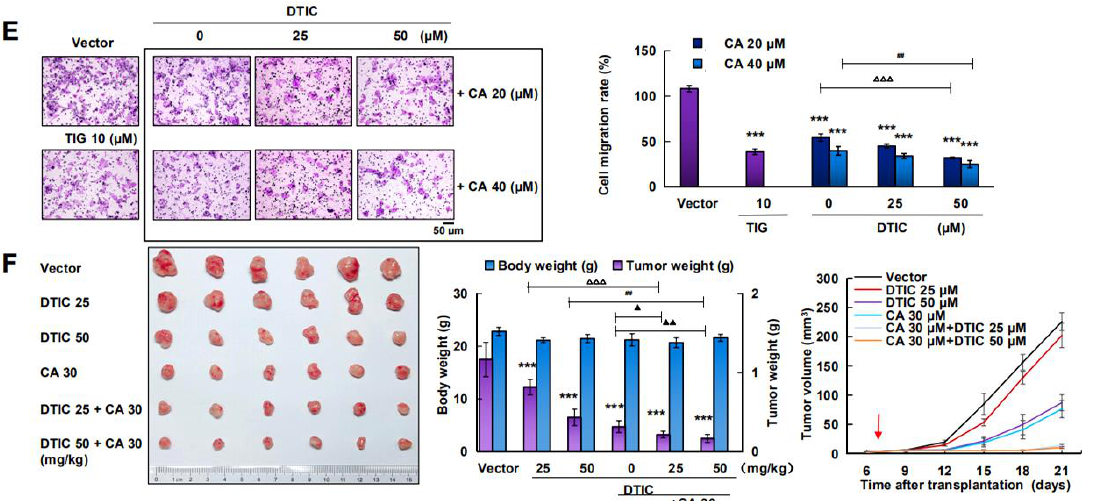
Figure 5. CA treatment showed a promoting e ff ect with DTIC in vitro and in vivo. ( A , B ) A375 cells were treated with DTIC for 72 h, the inhibition rate was assayed, and the IC 50 value was calculated. * p < 0.05, ** p < 0.01 versus no CA group ( n = 3). ( C ) The cooperativity index (CI) value reflecting the synergism of two medicines was calculated using CompuSyn software. CI values of < 1, 1, and > 1 indicate synergistic, additive, and antagonistic e ff ects, respectively. ( D ) Cells were treated with 0, 25, or 50 µ M DTIC and with 0, 20, or 40 µ M CA for 24 h and were analyzed with a flow cytometry system, and the G0 / G1 ratio was calculated. *** p < 0.001 versus the “DTIC 25 alone” group in G2M / G0G1, ∆∆∆ p < 0.001 versus the “DTIC 25 alone” group in S / G0G1, (cid:78)(cid:78)(cid:78) p < 0.001 versus the “DTIC 50 alone” group in G2M / G0G1, and ### p < 0.001 versus the “DTIC 50 alone” group in S / G0G1. ( E ) Cells were treated with TIG (10 µ M as a positive control), DTIC (25 or 50 µ M), or CA (20 or 40 µ M) for 24 h, and the migration rate was normalized by proliferation. *** p < 0.001 versus the “vector” group, ∆∆∆ p < 0.001 versus the “CA 20 + DTIC 0” group, and ## p < 0.01 versus the “CA 40 + DTIC 0” group ( n = 3), scale bar: 50 µ m. ( F ) The cells were subcutaneously injected into nude mice. When the tumors had formed for one week, mice were treated with the combination of DITC (25 or 50 mg / kg) and CA (30 mg / kg) or either medicine alone every day for two weeks (the red arrow at Day 7 was represent the first day of treatment). Average mouse weight and tumor weight are shown, and the tumor volume was calculated. * p < 0.05, ** p < 0.05, *** p < 0.001 versus the “vector” group, ∆∆∆ p < 0.001 versus the “DTIC 25 mg / kg” group, ## p < 0.01 versus the “DTIC 50 mg / kg” group, and (cid:78) p < 0.05, (cid:78)(cid:78) p < 0.01 versus the “CA 30 mg / kg” group ( n =